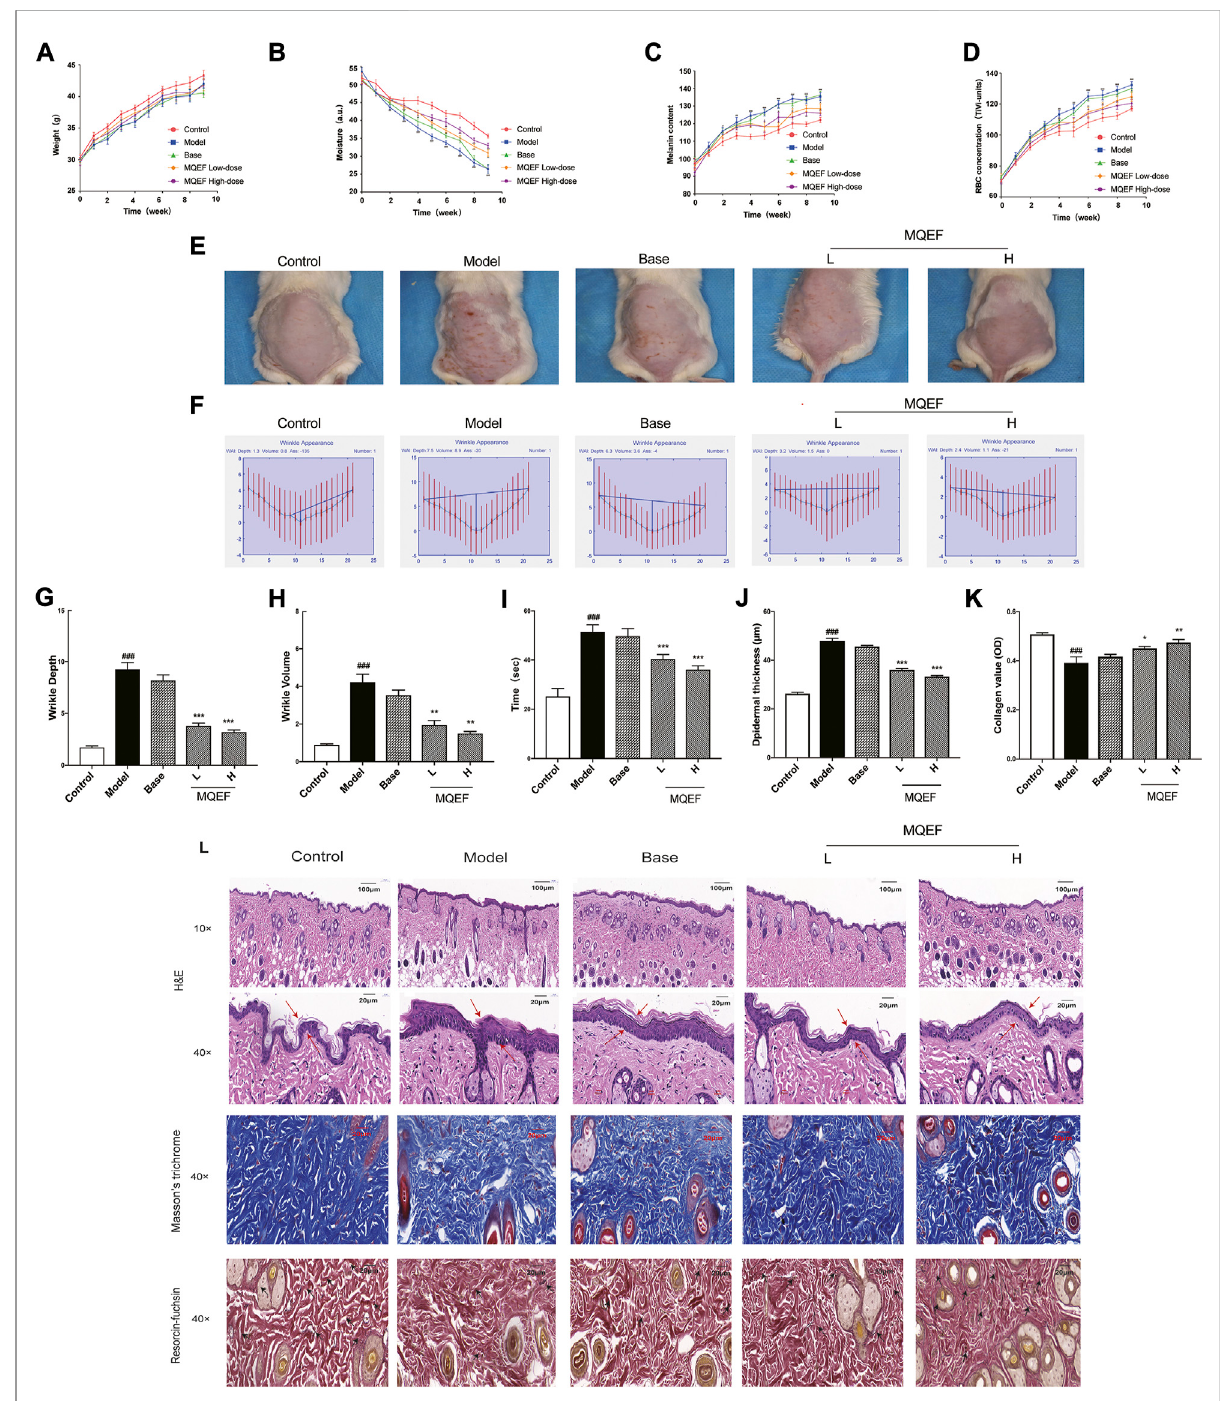
FIGURE 5 Modi fi ed Qing ’ e Formula (MQEF) protects mice from UV-Induced skin damage. Mice were treated topically with 0.67, 1.33 mg/g MQEF as well as no compound treatment, and the irradiation doses for the fi rst week were minimal erythema (MED): UVB: 0.07 J/cm 2 and UVA: 0.7 J/cm 2 , followed by a steady increase in the weekly irradiation dose to a total radiation dose of 9.45 J/cm 2 for UVB and 94.5 J/cm 2 for UVA. The irradiation was administered 5 times a week for 9 weeks (A – D) Representative broken lines of body weight, skin moisture, melanin content and sensitivity of mice within 9 weeks of UV irradiation. (E) Representative images of the skin morphological changes in each group after 9 weeks of UV irradiation. (F – H) Theextentofwrinkledepthandvolumewasanalyzedbyimageanalysissystem. (I) Changesofskinelasticityineachgroupafter9 weeksofUV radiation. (J) Quanti fi cation of the epidermal thickness in Hematoxylin and Eosin (H&E) staining. (K) Quanti fi cation of the collagen value in Masson ’ s staining. (L) H&E staining was used to evaluate the tissue structure of mouse skin. Observe the thickness of the epidermis by the double